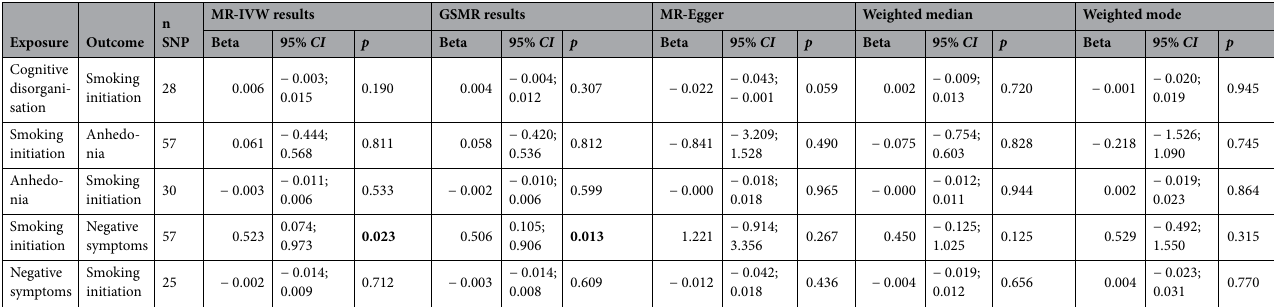
Table 2. Mendelian randomization results. GSMR, Generalized Summary-based Mendelian Randomization; MR-IVW, inverse-variance weighted Mendelian randomization; n SNPs, number of variants remaining in analyses after those identified as Heidi-outliers or with residual LD at r 2 > .1 were removed; PENS, psychotic experiences and negative symptom traits; SNPs identified as having residual LD and as Heidi outliers were also excluded from MR Egger, Weighted Median and Weighted Mode analyses; Bold text indicates significant p values at p < 0.05. a Summary statistics for smoking initiation excluded UK Biobank participants in analyses on major depression and adult psychotic experiences to avoid overlapping samples (N =